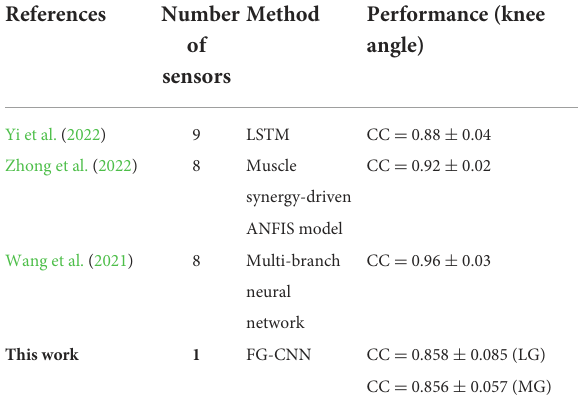
TABLE 2 Comparison with related